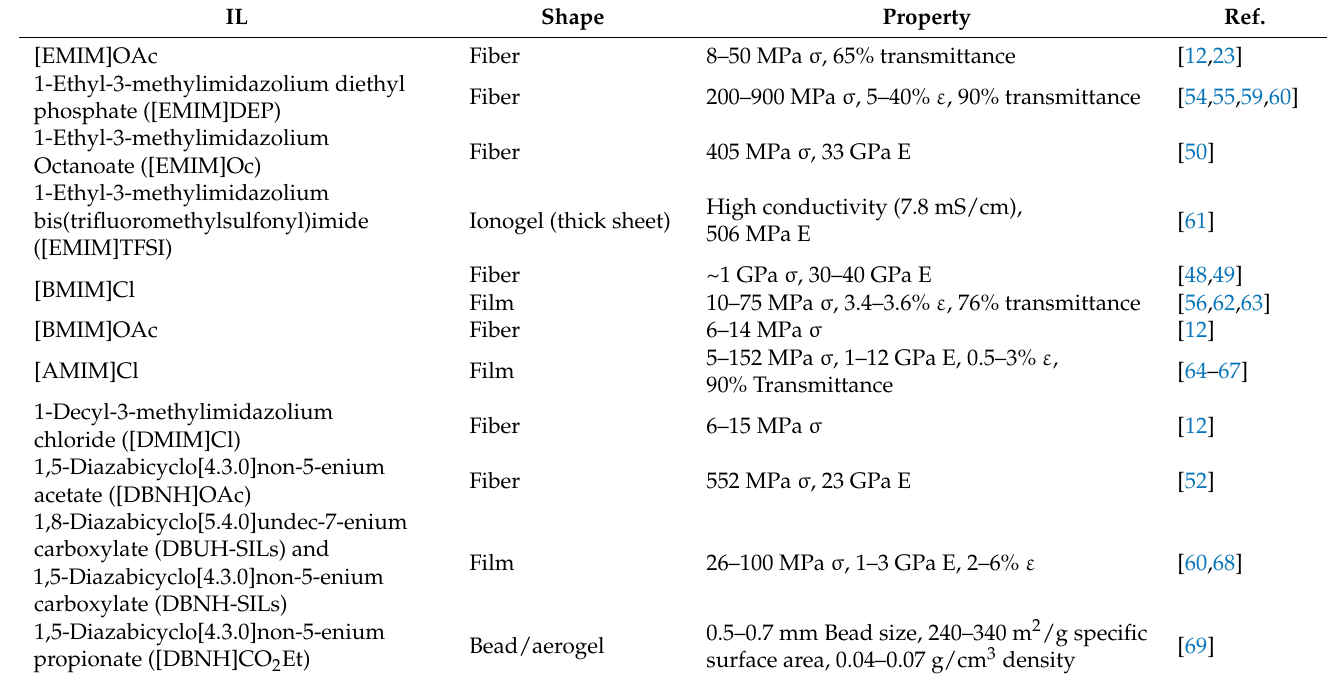
Table 2. ILs and properties of the shaped regenerated cellulose in terms of transparency (% light transmittance), tensile strength ( σ ), Young’s modulus (E), and elongation at break ( ε ).